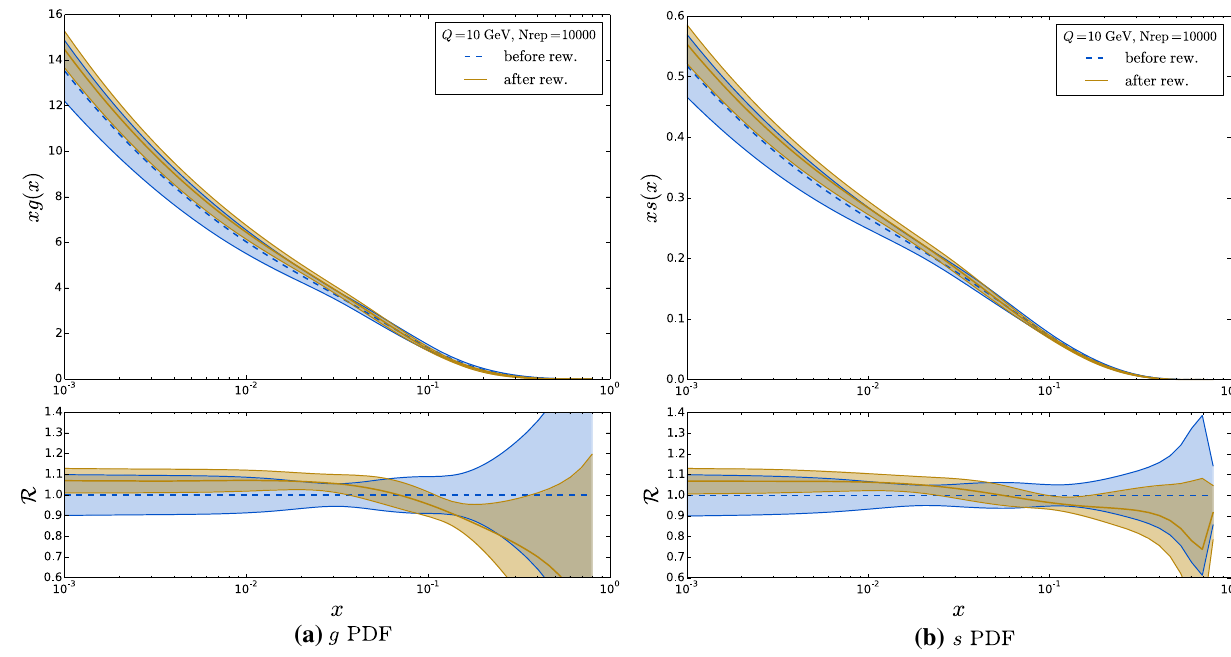
Fig. 29 g and s PDFs before and after the reweighting using all LHC pPb data